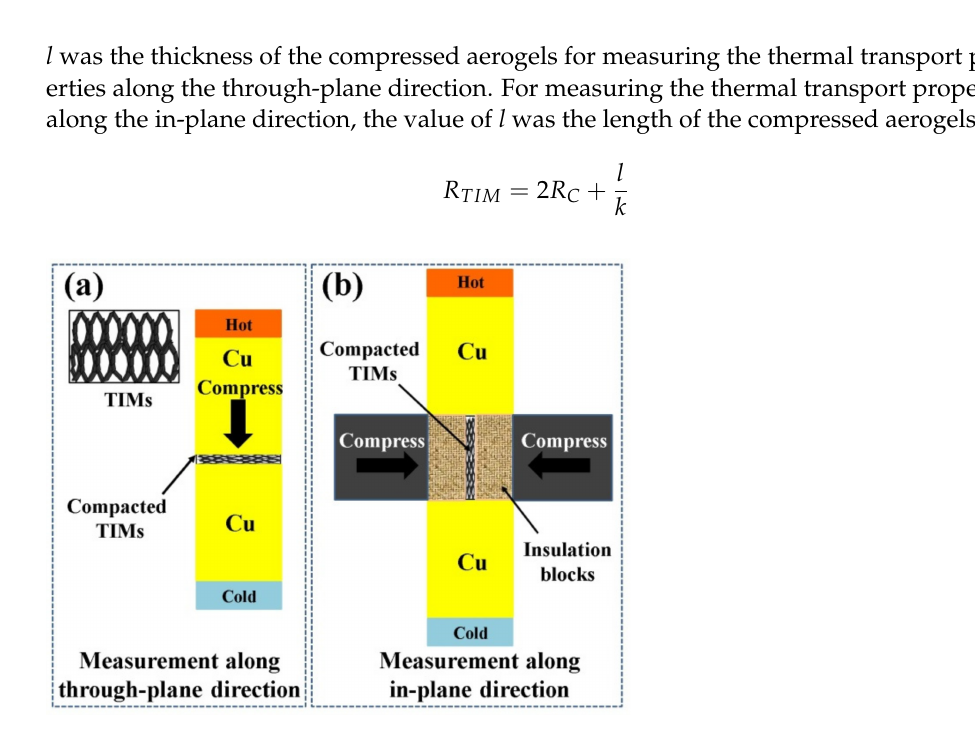
Figure 1. Illustration for testing the thermal transport properties of aerogel thermal interface materials (TIMs) along ( a ) through-plane direction and ( b ) in-plane direction, respectively.